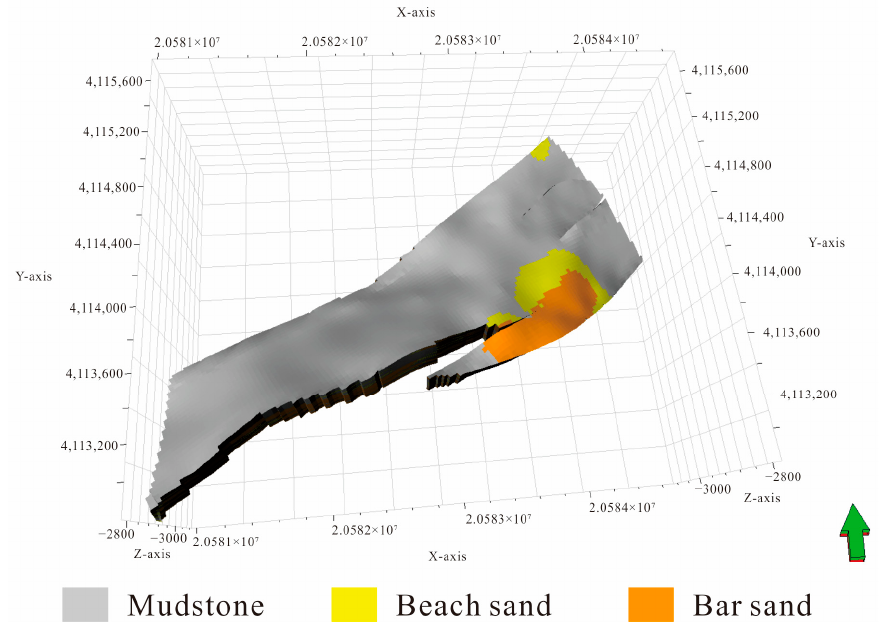
Figure 13. Sandstone-mudstone model of undifferentiated beach and bar sand in Gao89-1 block.